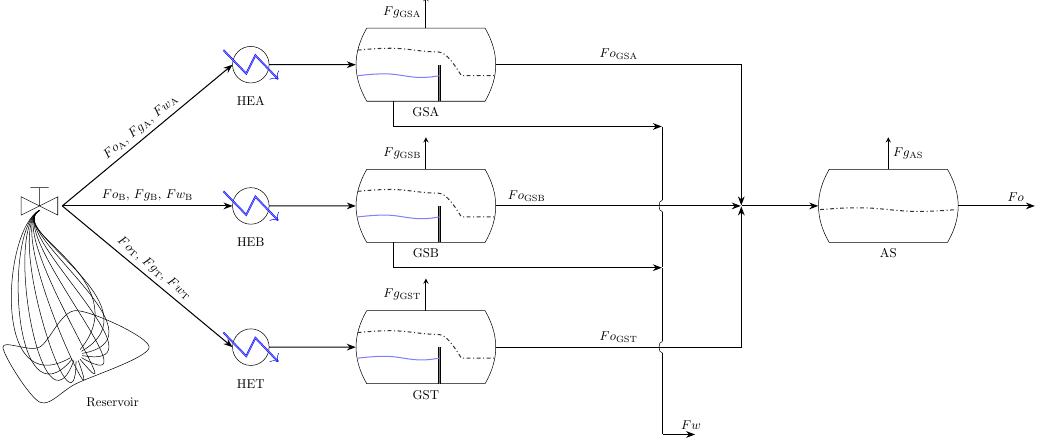
Figure 1. Simplified diagram of the oil processing plant